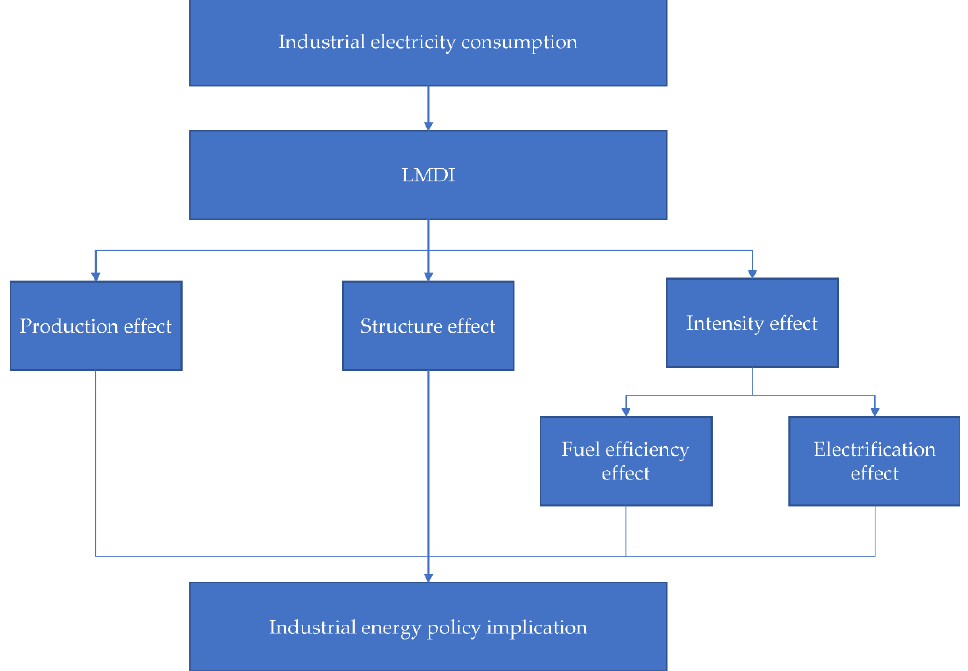
Figure 2. LMDI scheme in the study.